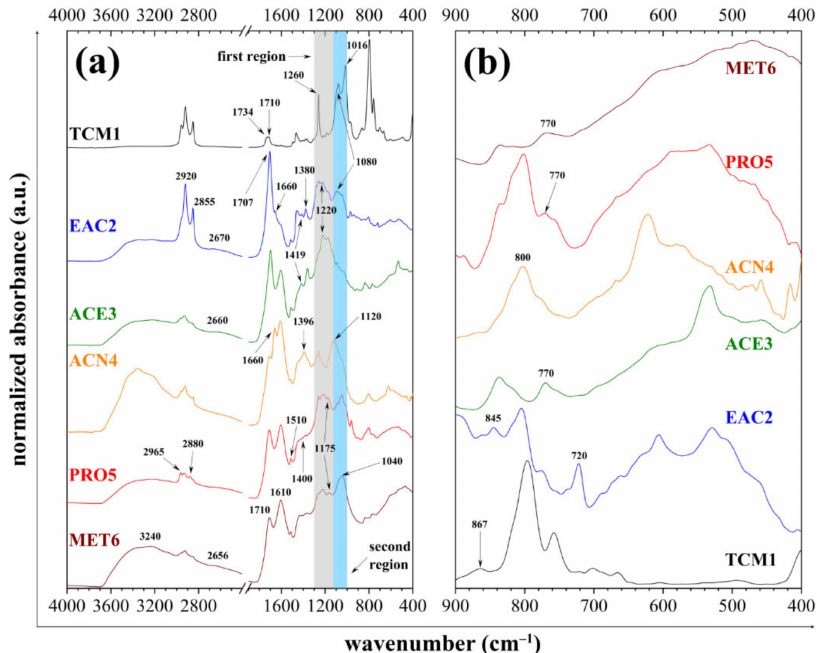
Figure 1. Attenuated Total Reflectance (ATR-FTIR) spectra of organic fractions extracted from peat HA, ( a ) spectral range of 4000–400 cm − 1 and ( b ) spectral range of 900–400 cm − 1 for the visualization of less intense absorption